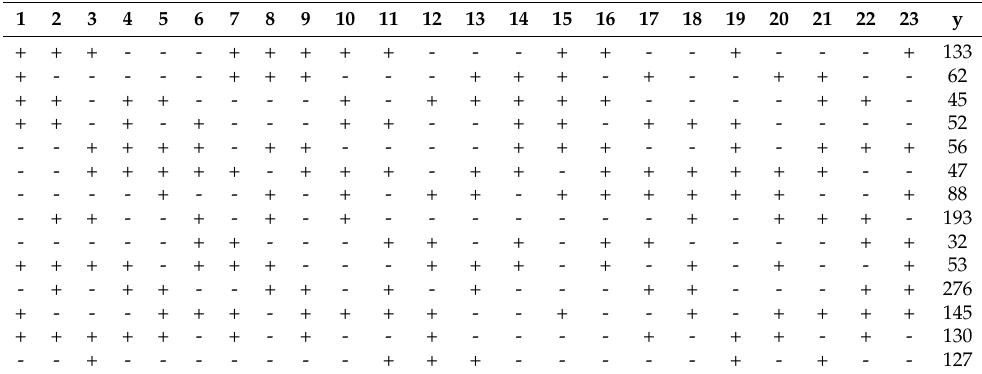
Table 4. The Williams’ data—rubber age data.